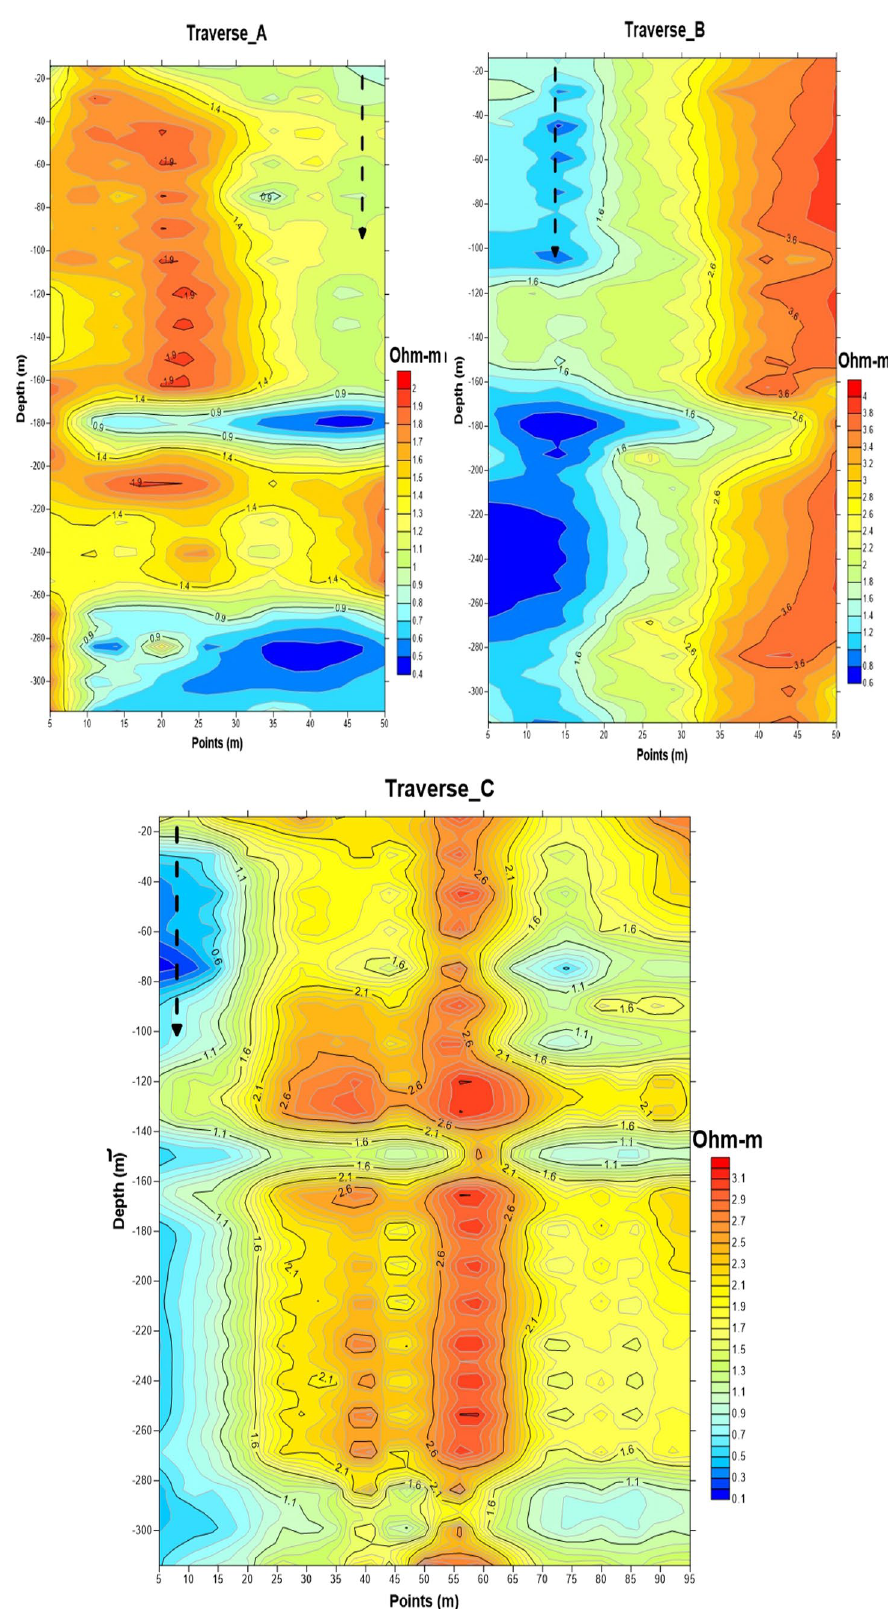
Fig. 2 2D-Apparent Geo-Elec- trical Resistivity Pseudo-sec- tions of the surface at the study area underlain by the Birimian rocks ( A , B , C